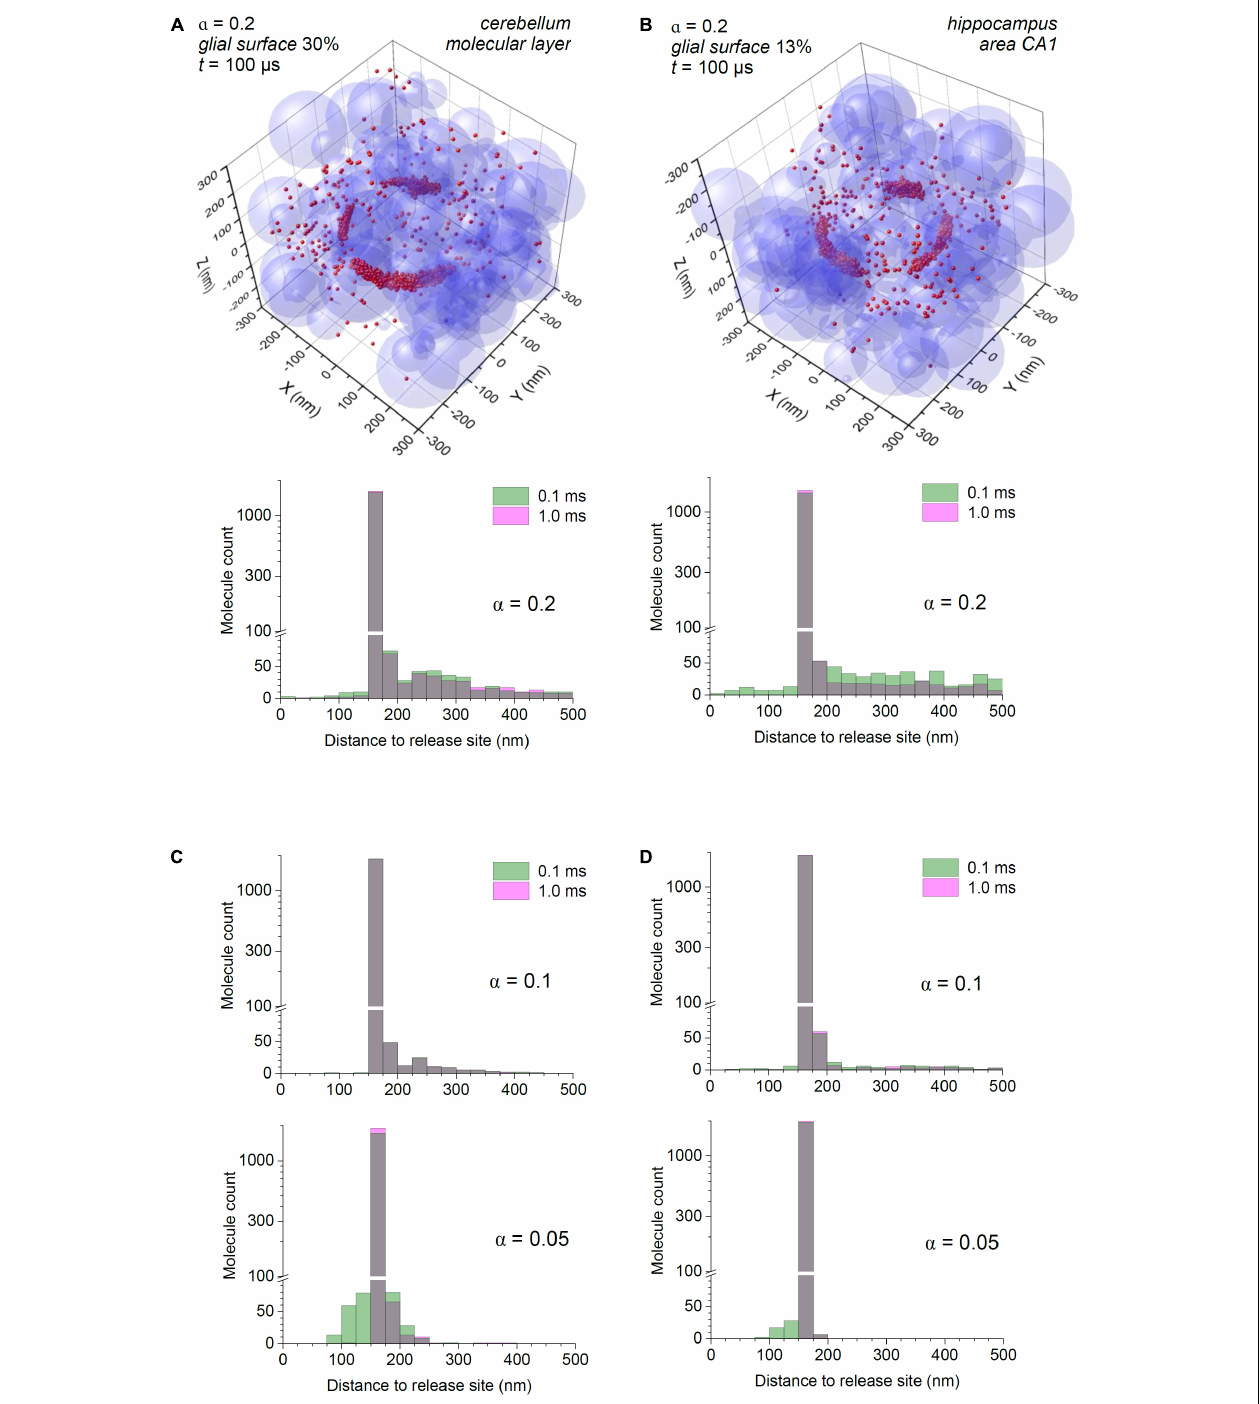
FIGURE 2 | Astroglial high-affinity transporters control the scatter of escaping glutamate molecules in the modelled cerebellar and hippocampal neuropil. (A) Simulations as in Figure 1B , with the synaptic cleft (diameter 320 nm, height 20 nm) placed in the co-ordinate origin (also glutamate release site); particle-surface binding enabled, for each particle with probability of 0.3 (to mimic 30% chance of encountering cell membranes representing astroglia); medium porosity α = 0.2. Histogram: spatial distribution of glutamate molecules (free and transporter-bound combined) across the simulation arena, at two time points post-release, as indicated; note two scales (one log-scale) of the ordinate. (B) Simulations as in (A) , with the particle-surface binding enabled, for each particle with probability of 0.13 (to mimic 13% of neuropil cell membranes representing astroglia); other notations as in (A) . (C) Simulation outcome (molecule distribution histograms) for the model shown (A) , but with tissue porosity values α = 0.1 and α = 0.05, as indicated); other notations as in (A) . (D) Simulation outcome (molecule distribution histograms) for the model shown (B) , but with tissue porosity values α = 0.1 and α = 0.05, as indicated); other notations as in (B) .